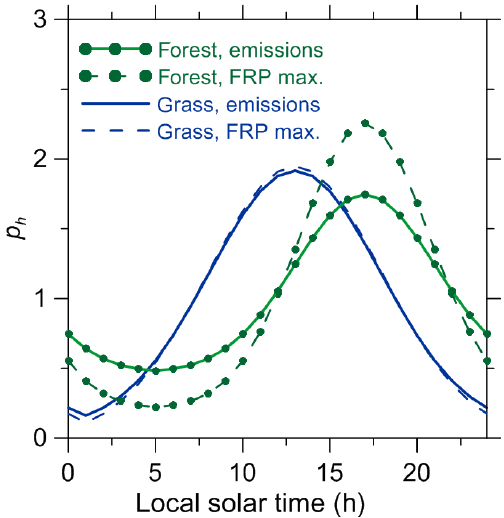
Figure 1. Diurnal profiles of fire emissions ( h e (t) ) and daily FRP maxima ( h m (t) ) used in the emission model (see Eqs. 3 and 5).